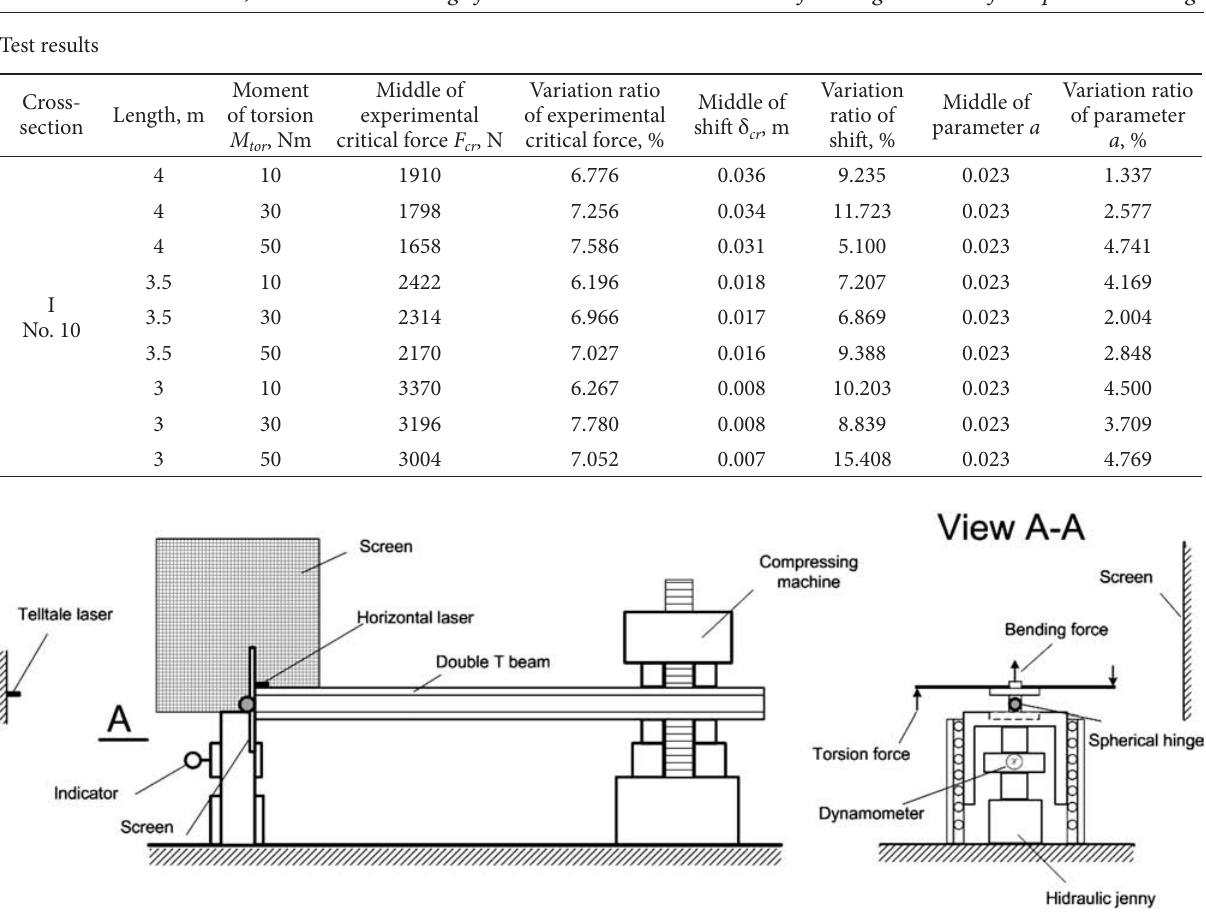
fig. 3. Test diagram for supported beam